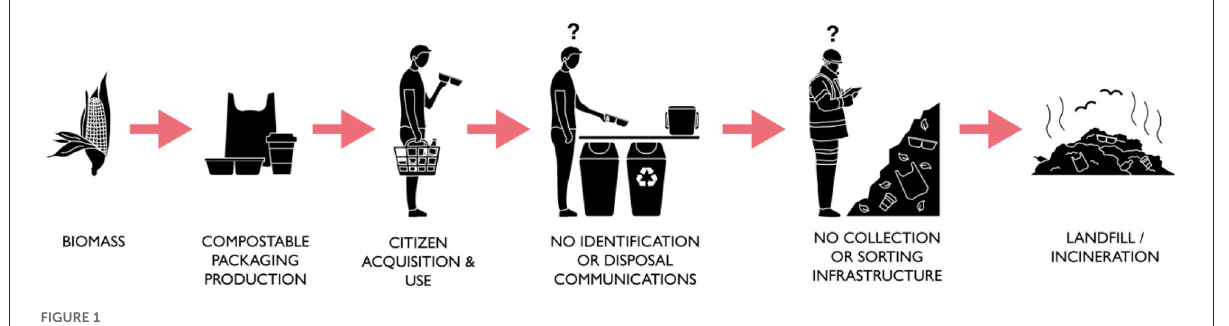
FIGURE1 A linear economy of compostable